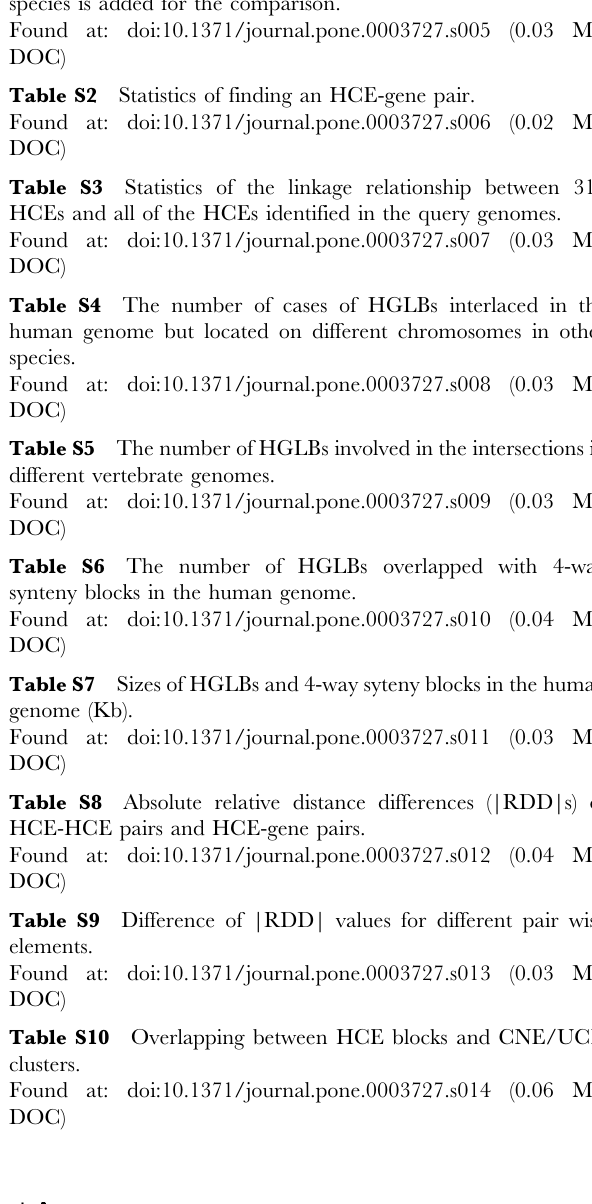
Table S10 Overlapping between HCE blocks and CNE/UCR clusters.